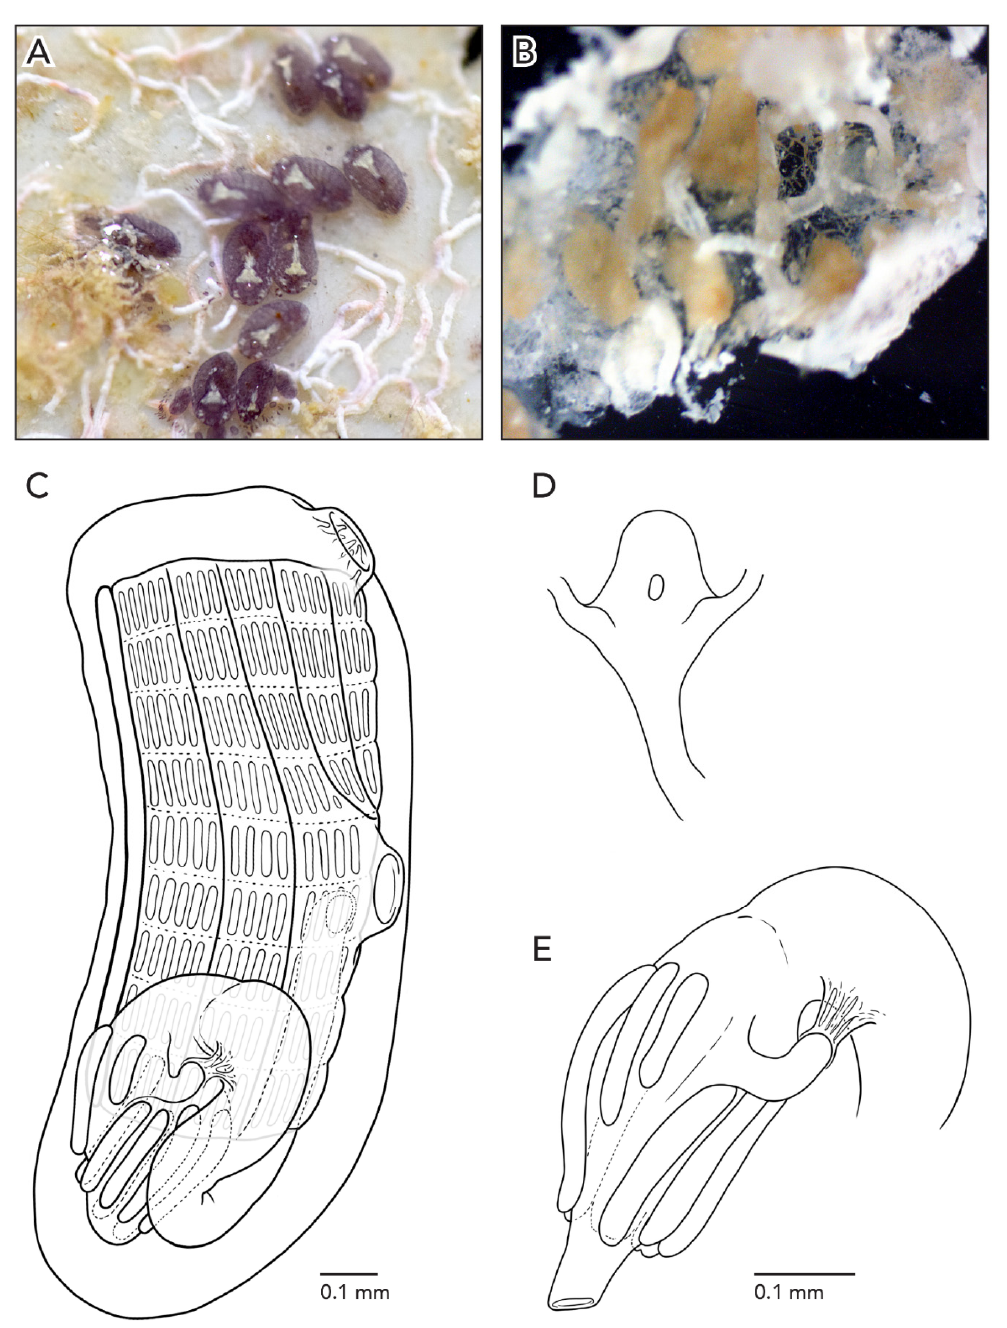
Figure 16. Symplegma sp. ( A ) Living colony on artificial substrate (PVC) ( B ) Preserved colony ( C ) Left side view of a zooid ( D ) Peritubercular area ( E ) Detail of the abdomen region. The colony has a thin and transparent tunic and the zooids are perfectly visible through the surface. Zooids are purple with a yellow triangle dorsally and two additional